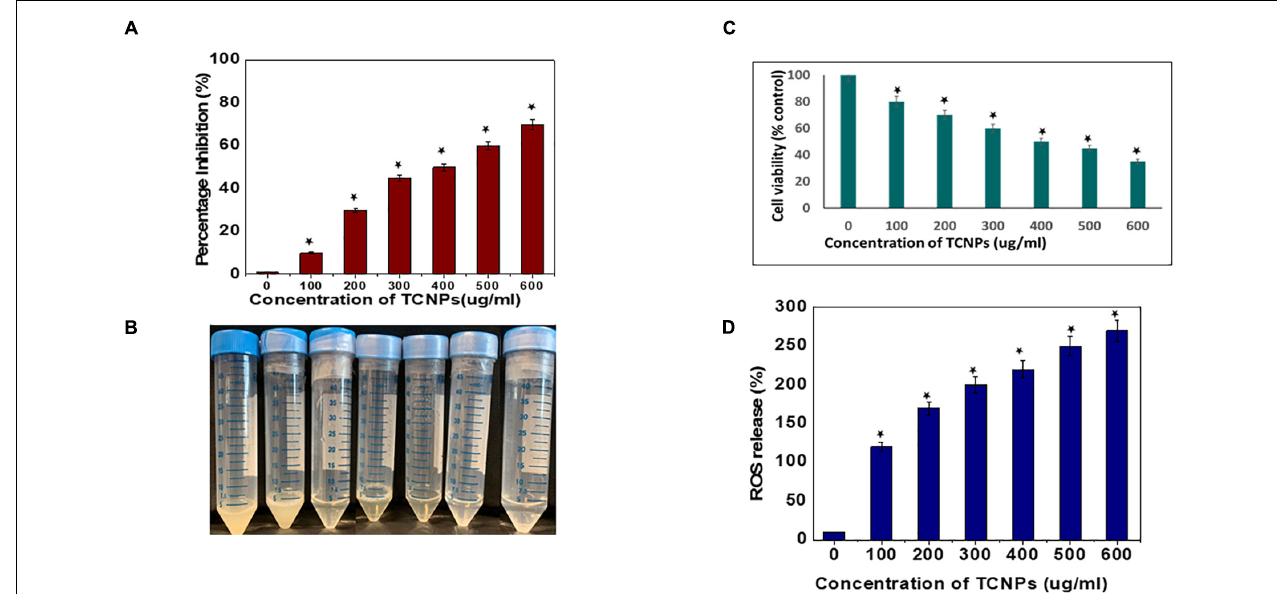
FIGURE 2 | In vitro antibacterial activity of the thymol loaded chitosan nanoparticles. (A) ln vitro antibacterial activity in liquid broth. (B) Image of tubes depicting the inhibition visually. (C) Percentage of cell viability of the bacterial cells by MTT assay. (D) Percentage of reactive oxygen species released. Data are represented as mean ± SD of three independent experiments, each performed in triplicates and considered statistically significant when * p < 0.05.